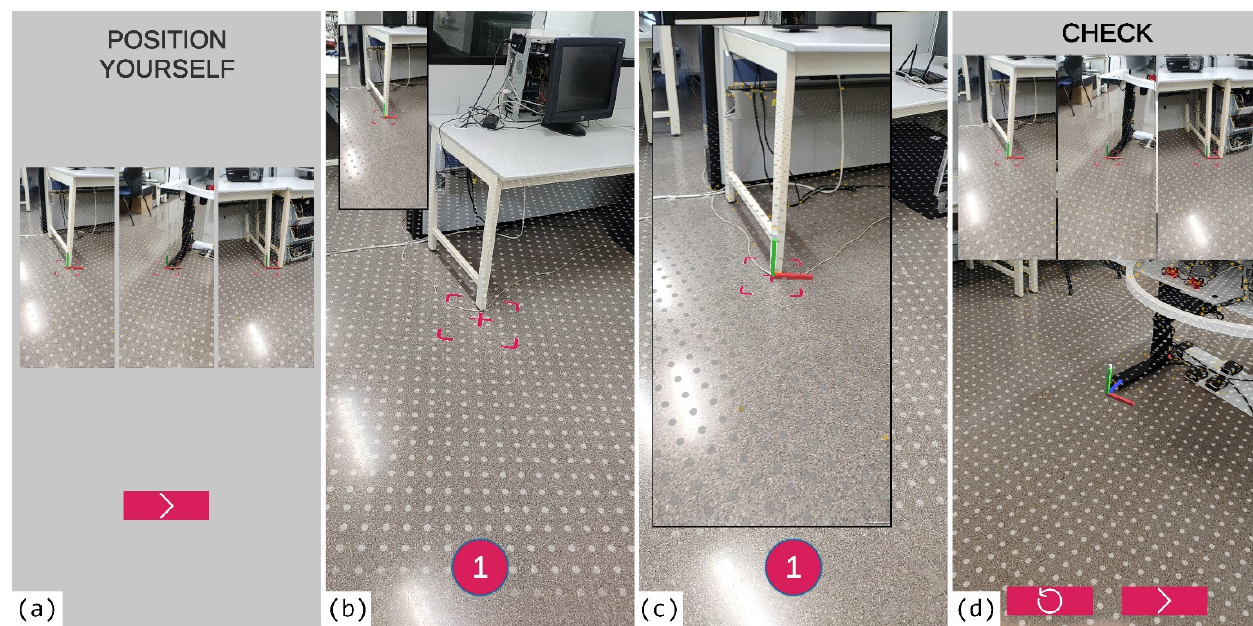
Figure 4. Screenshots of the application during the calibration process.